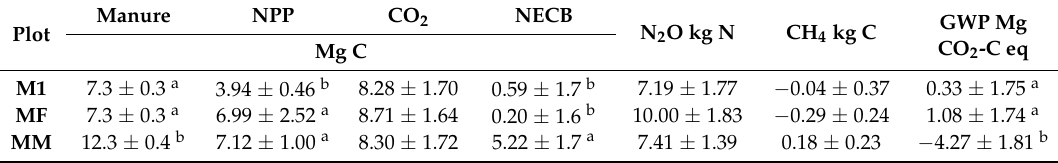
Table 3. Average annual manure C input, net primary production (NPP), CO 2 emission, net